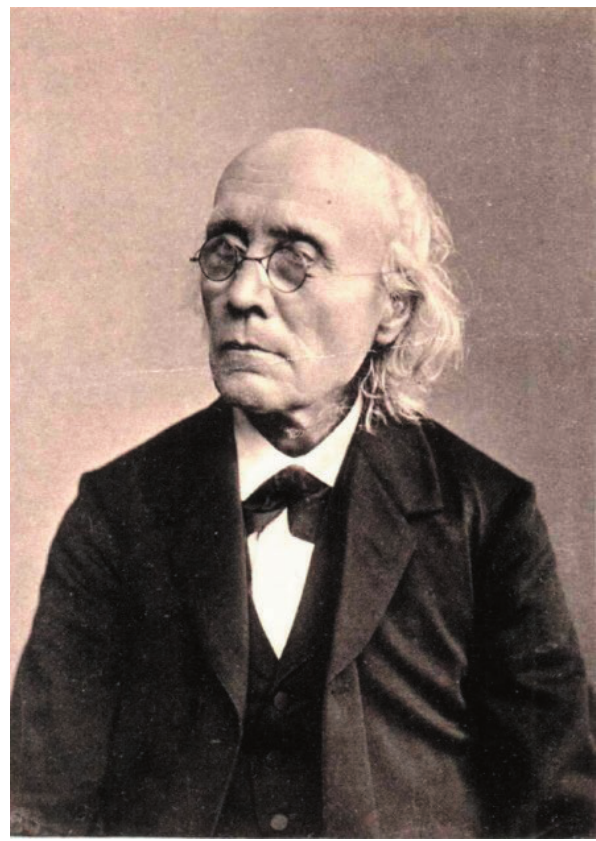
Figure 3. Portrait of Gustav Theodor Fechner (1801 – 1887). Date and author unknown. Source, ref. [64] , public